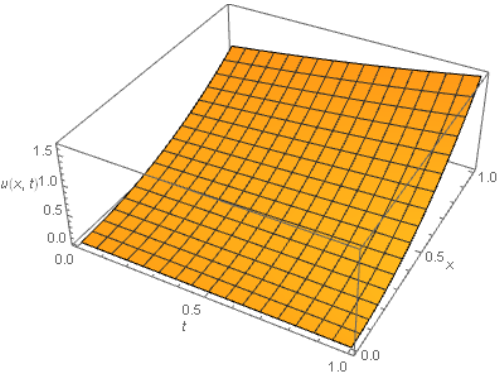
Figure 1:3D exact Solution of example1 Figure 1. 3D exact Solution of Example 1 with α = 1. with (cid:11) = 1